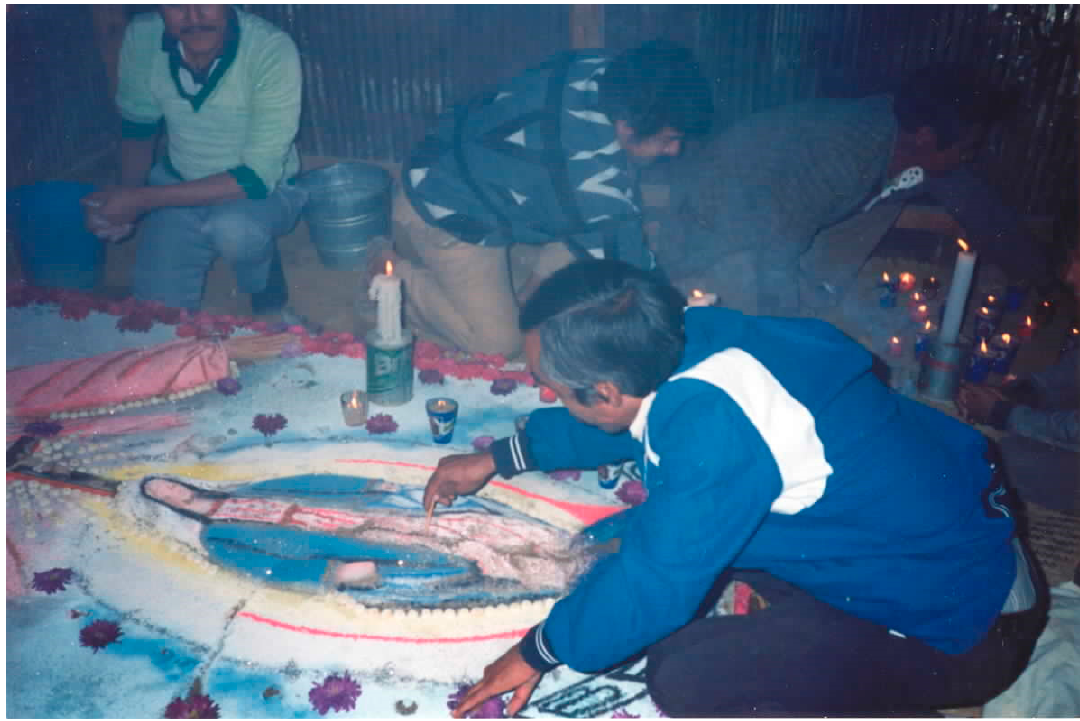
Figure 1. Dividing the Novenario “ tapete” for the Levantada de la Cruz ceremony (photo by author).